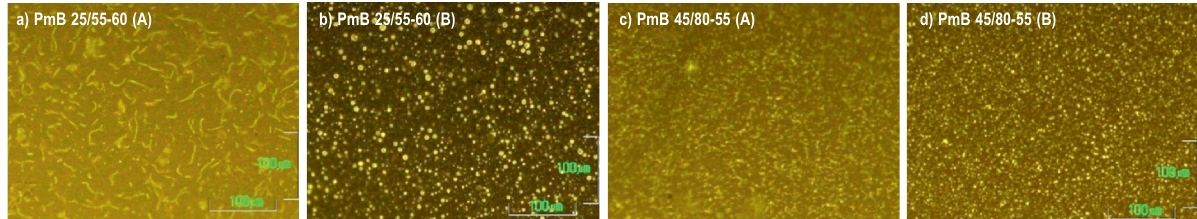
Fig. 13. Microstructure of the polymer modified bitumen